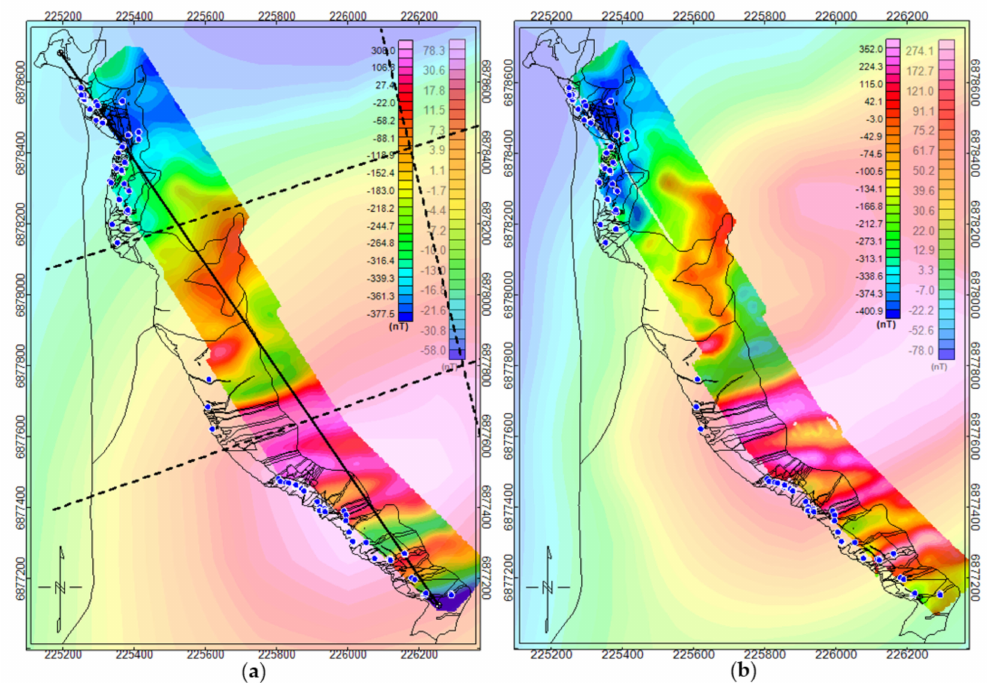
Figure 4. Magnetic map of the study area: ( a ) the magnetic anomaly on the left and ( b ) the anomaly reduced to the pole, on the right. Pale colors refer to the regional aeromagnetic map and bright colors, to the local drone-borne magnetic survey. Geological contours are superimposed in black and dark blue dots localize field magnetic susceptibility measurements. Location of modelled magnetic profiles represented as thick black dotted lines; the profile along the coast is presented in the following figures. Table 1. Statistics of magnetic susceptibility measurements performed on each geological facies outcropping in the study area. A factor of 10 − 3 applies for SI units. In the Lithology descriptions, Bt and Hbl stand for biotite and hornblende respectively.